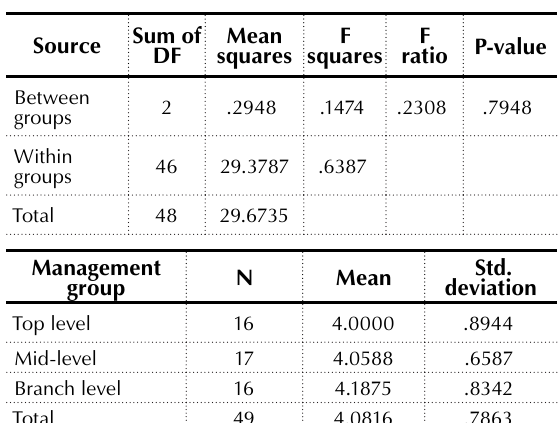
Table 4. Analysis of variance for mean differences between the three management